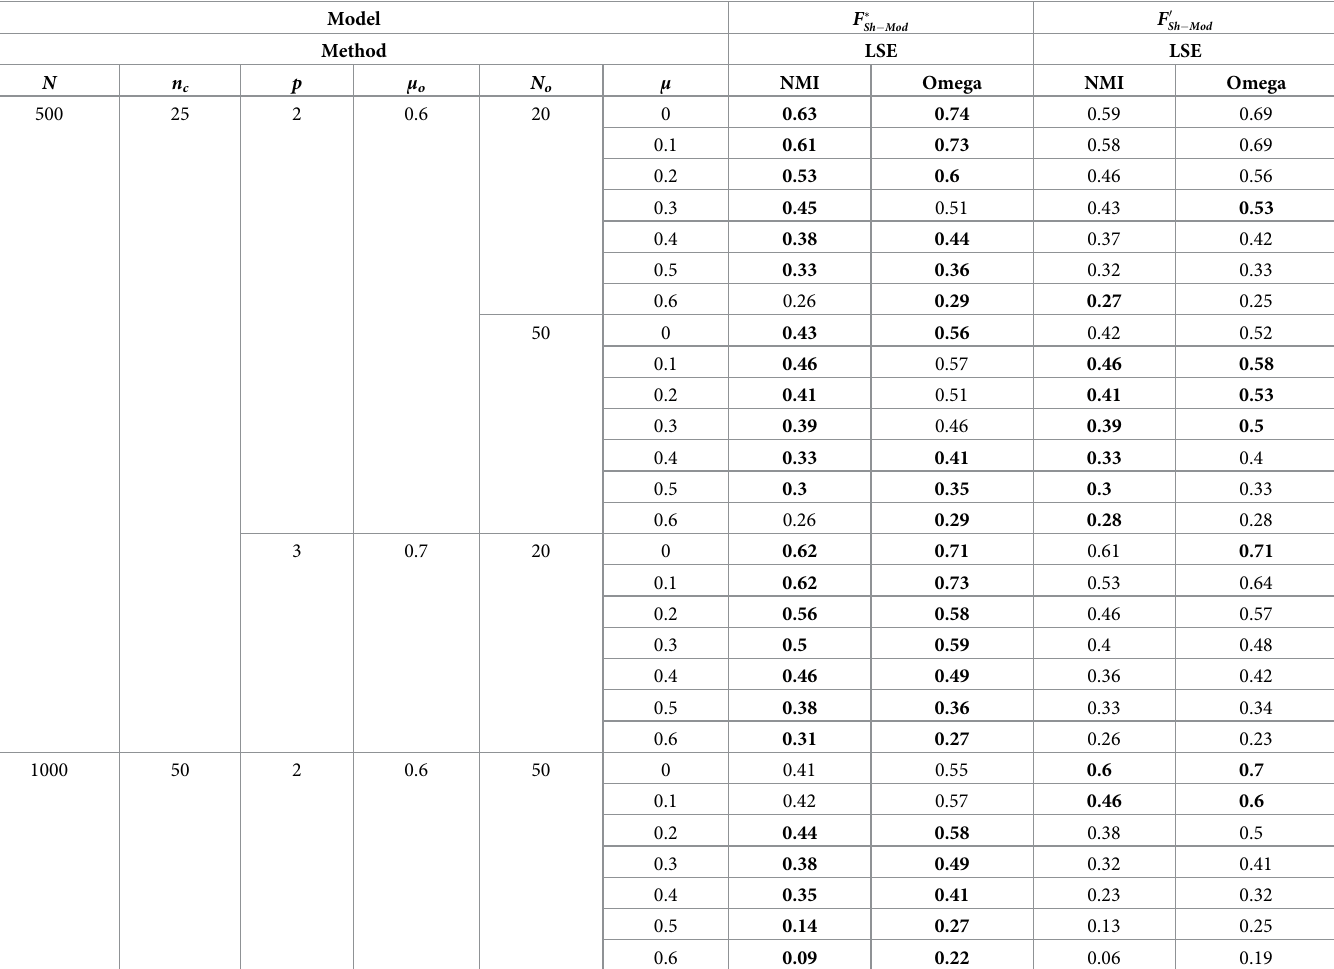
Table 4. Computational results about large-scale networks with overlapping communities.